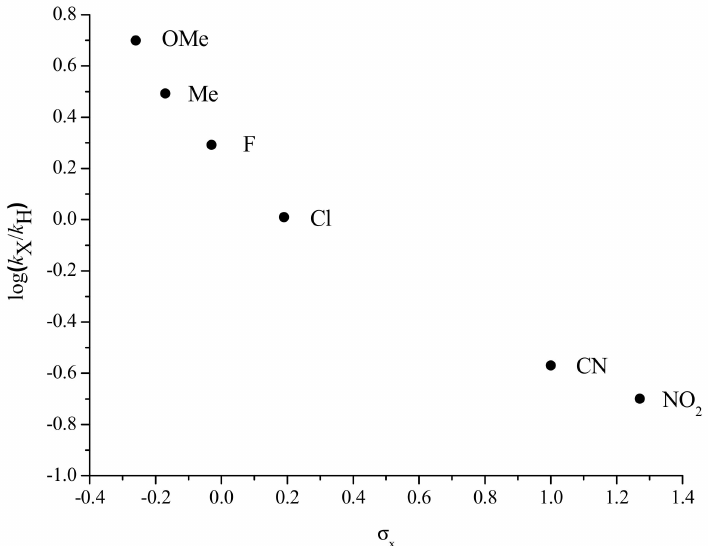
Figure 3. Hammett plot for the reduction in Cu(I) (1 mM) by para -substituted phenylboronic deriva- tives ( p -X-C 6 H 4 )B(OH) 2 (10 mM) (X = MeO, Me, F, Cl, CN and NO 2 ) in the presence of TBAOH (8 mM) (see Figure S11 for the fit of the associated kinetics); k H pseudo first-order rate constant for X = H, k X pseudo first-order rate constant for a substituent